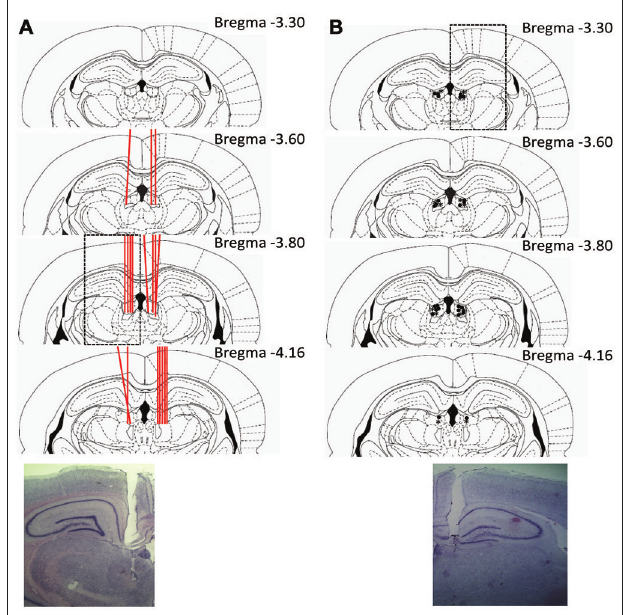
FIGURE 3 | Summary of histological results. (A) Experiment 1 example section and schematic of tetrode placements within the LHb. Individual tetrode tracts are represented with red lines passing through the LHb. (B) Example and schematic of cannula placements for experiment 2. Injection cannula locations are represented with ∗ ’s for experiment 2a, and • ’s for experiment